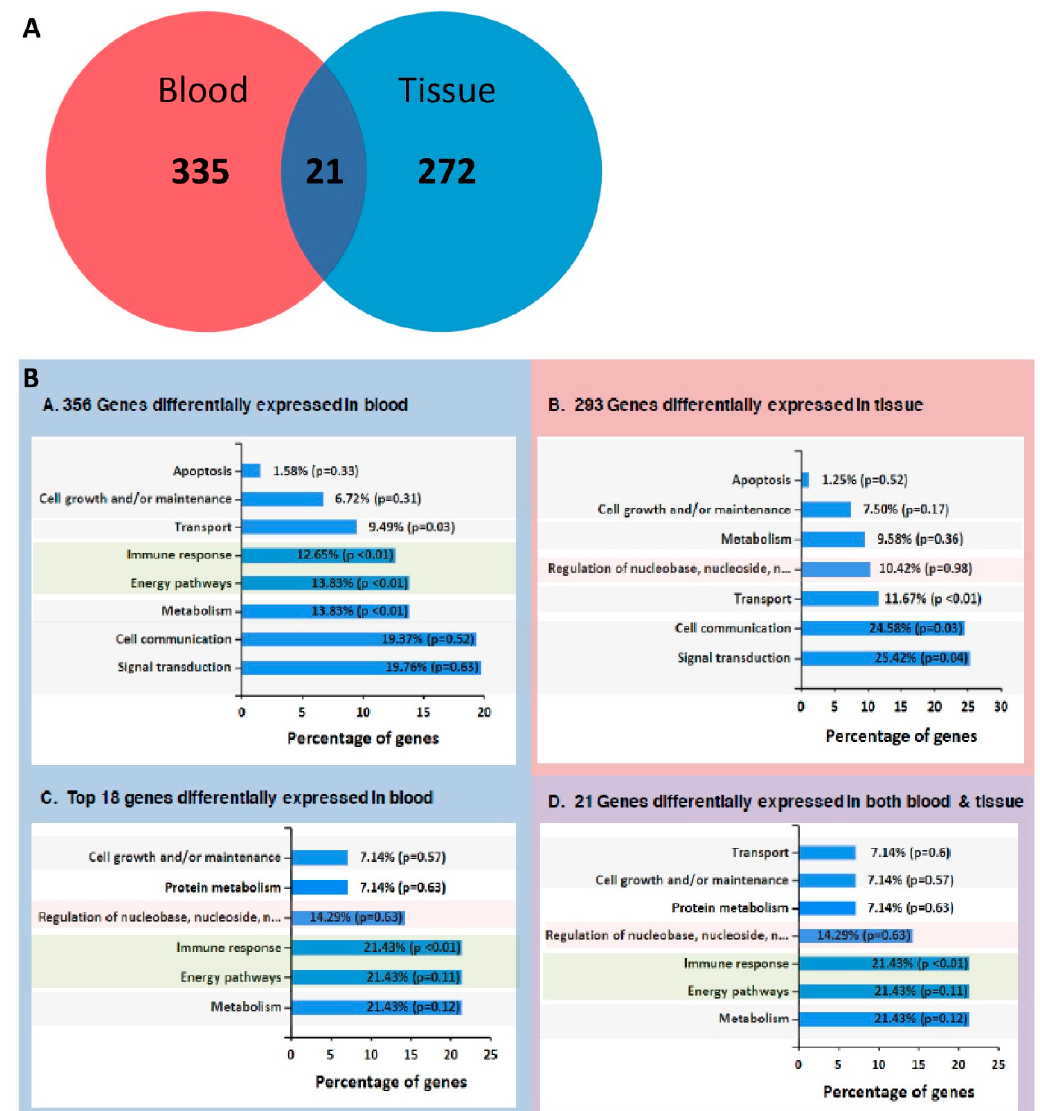
Figure 3. Venn diagram of differential expressed genes in blood and tissue. Panel ( A ): A total of 272 genes were shown to be differentially expressed in tumour tissue compared to controls, and 335 in cancer blood samples compared to controls. Twenty one genes show statistically significant differential expression pattern in both tissue and blood samples compared to control. Panel ( B ): Details on top GO terms resulting from functional enrichment analysis using Fun Rich software, for differentially expressed genes in blood (356), tumour tissue (293), blood only (18), and in both blood and tumour (21) compared to controls (Panels A – D in B ).